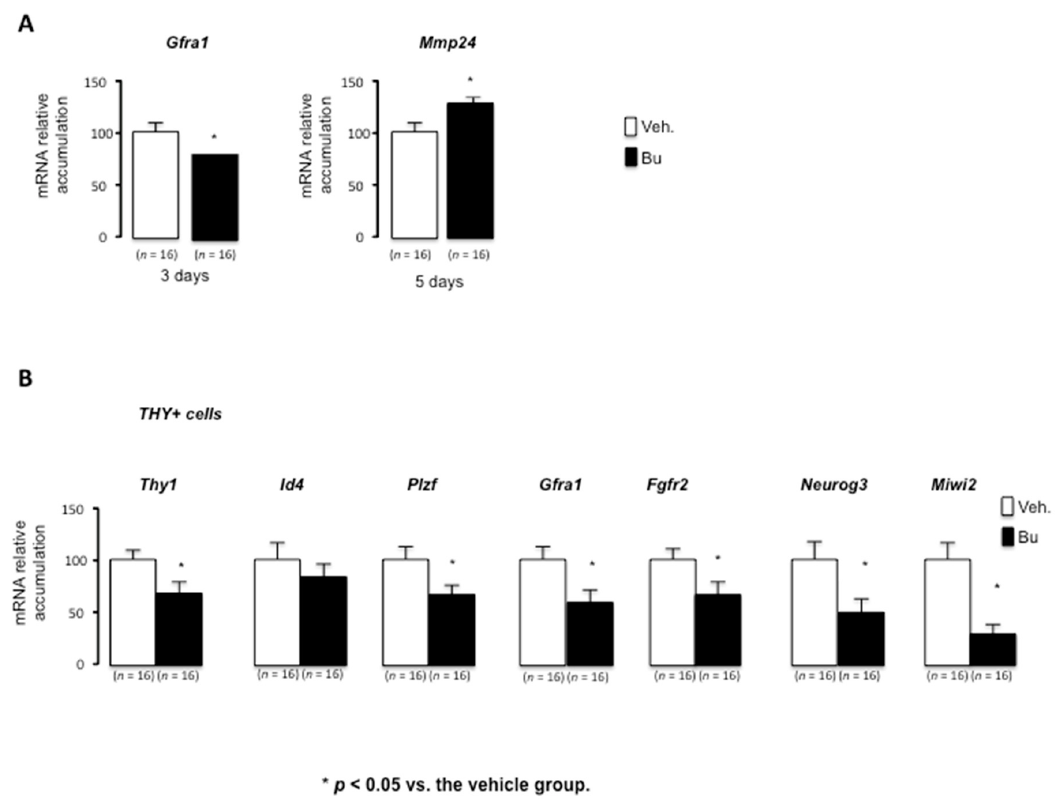
Figure 6. Busulfan alters key genes of undifferentiated spermatogonia in male mice. ( A ) Relative Gfra1 and Mmp24 mRNA accumulation normalized to β -actin on testes after exposure to vehicle or Bu after 3 or 5 days following exposure. ( B ) Relative Thy1 , Id4 , Plzf , Gfra1 , Fgfr2 , Neurog3 , and Miwi2 mRNA accumulation normalized to β -actin on FACS cell-sorted Thy1+ cells 1 week after exposure to vehicle or Bu. The data are expressed as the means ± SEM. Statistical analysis: * p < 0.05 vs. the vehicle group. Veh.: vehicle and Bu: busulfan.